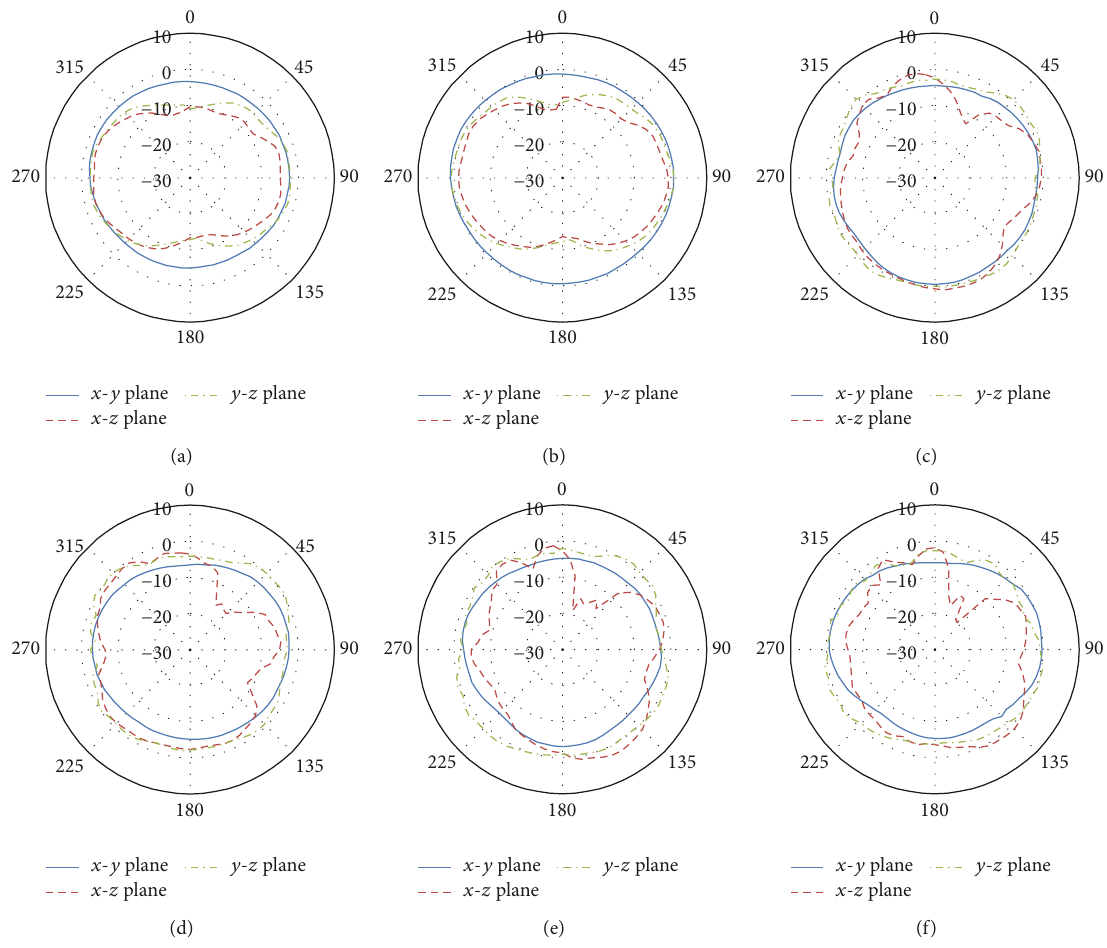
Figure 7: Measured radiation gain patterns of the proposed antenna at (a) 0.84, (b) 0.94, (c) 1.82, (d) 2.1, (e) 2.4, and (f) 2.69 GHz.